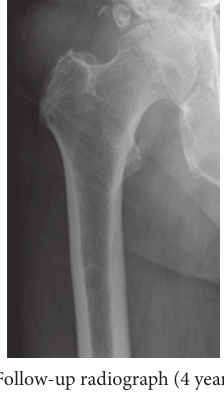
Figure 7: True negative (CTRA-/Fx-) (Case 6, R femur). (a) This is a 79-year-old male with a 12-year history of multiple myeloma demonstrating osteolytic lesions within the right subtrochanteric femur. (b) CTRA and FEA were both run and did not predict fracture for this subject. (c) The patient was followed for several years, and follow-up imaging at four years demonstrates minimal change to the subtrochanteric